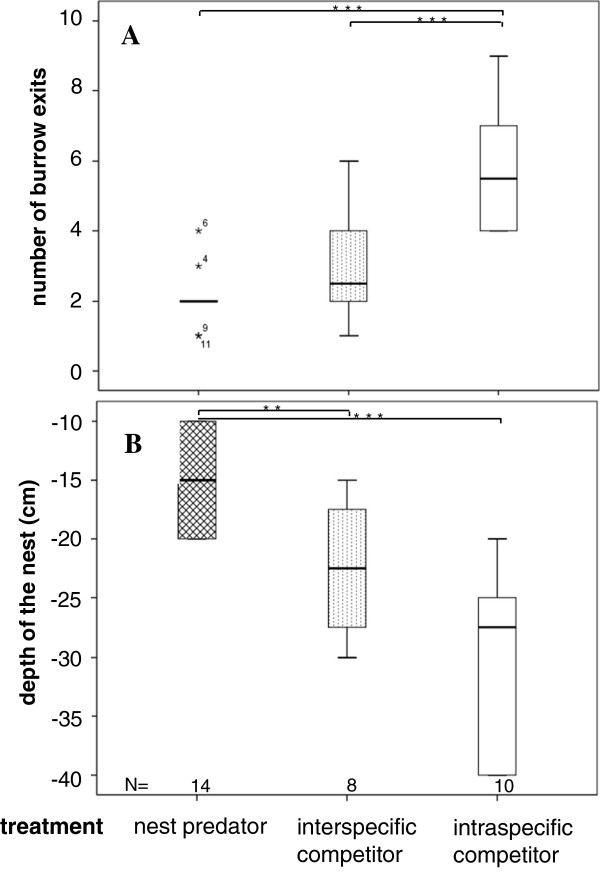
Number of the burrow entrances (A) and the depth of the nest (B) of vole females (Microtus arvalis) in the presence of a nest predator (NP, Greater white toothed shrew, Crocidura russula), or a interspecific resource competitor (RC, female field vole, M. agrestis) or a intraspecific competitor control (C, female common vole, M. arvalis). All burrow entrances were counted at day 22 of the experiment when vole nestlings were 3 days old. Please note that the y axis in (B) is negatively scaled (0 = ground level), visualizing the direction of digging into the ground.